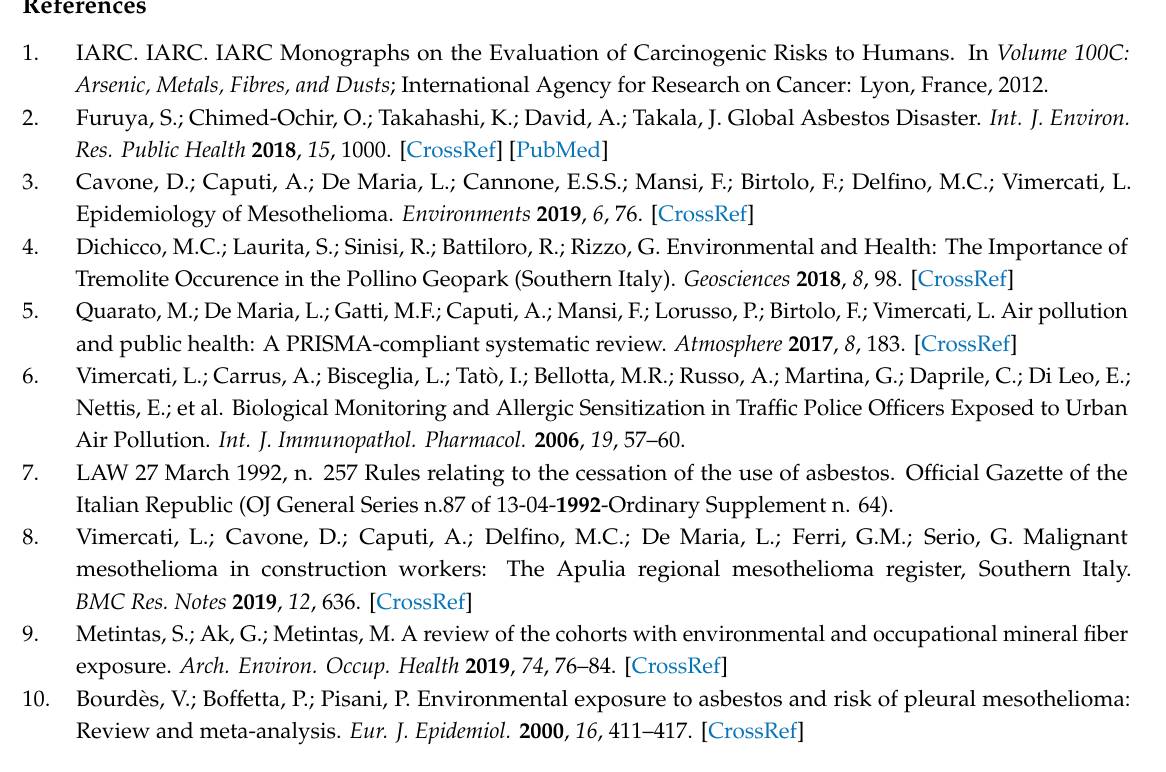
Figure S1: Scree plot showing high Eigenvalues ( > 1) only for the first two components. Table S1: The overall distribution by year of incidence and sex, Table S2: The overall distribution of the calendar years of the start of exposure and sex, Table S3: The overall distribution by residence distance from the factory and sex, Table S4: Univariate Risk (Ors) Epithelioid mesotheliomas by di ff erent variables, Table S5: Principal components / covariance of the studied variables, Table S6: Distributions of Eigenvalues by